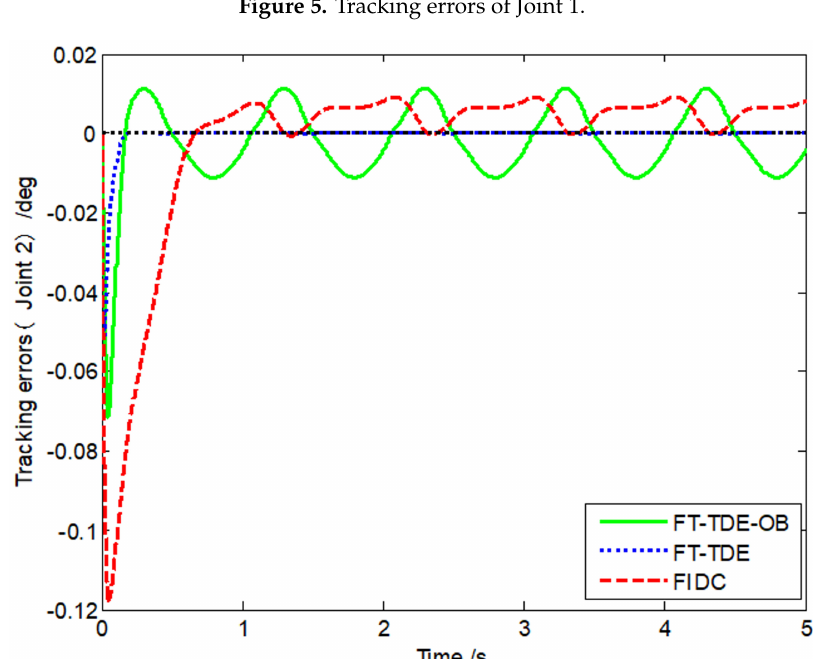
Figure 6. Tracking errors of Joint